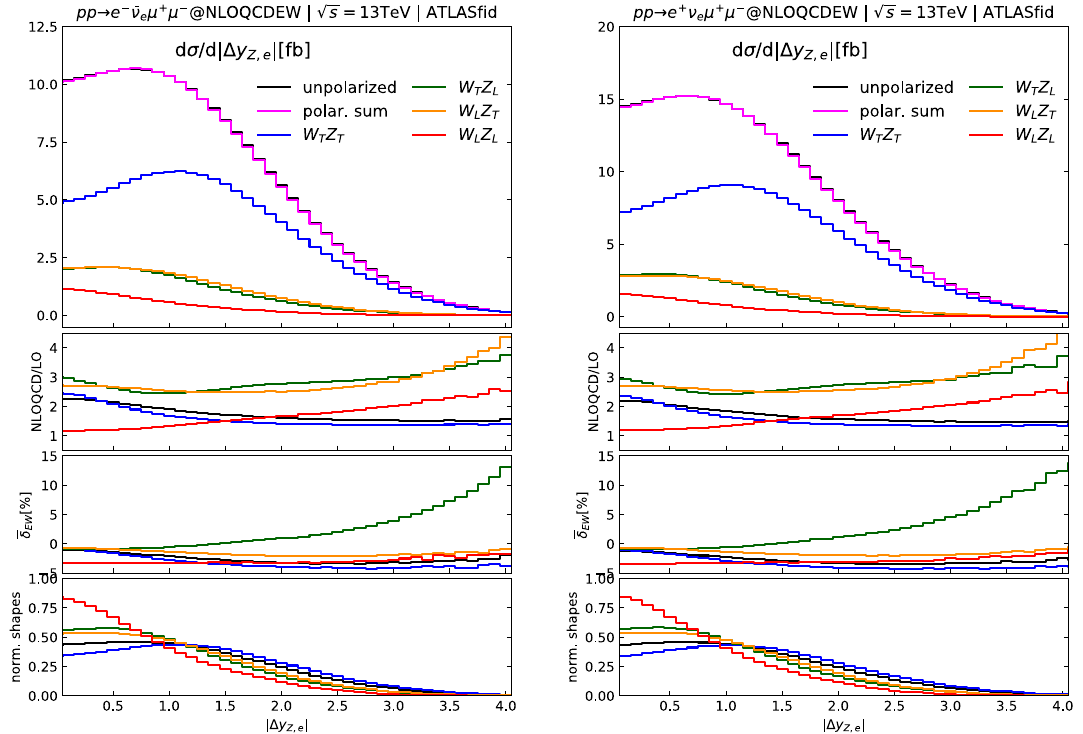
Fig. 5 Same as Fig. 2 but for the rapidity separation (in absolute value) between the electron/positron and the Z boson. The left plot is for the process W − Z while the right plot is W +